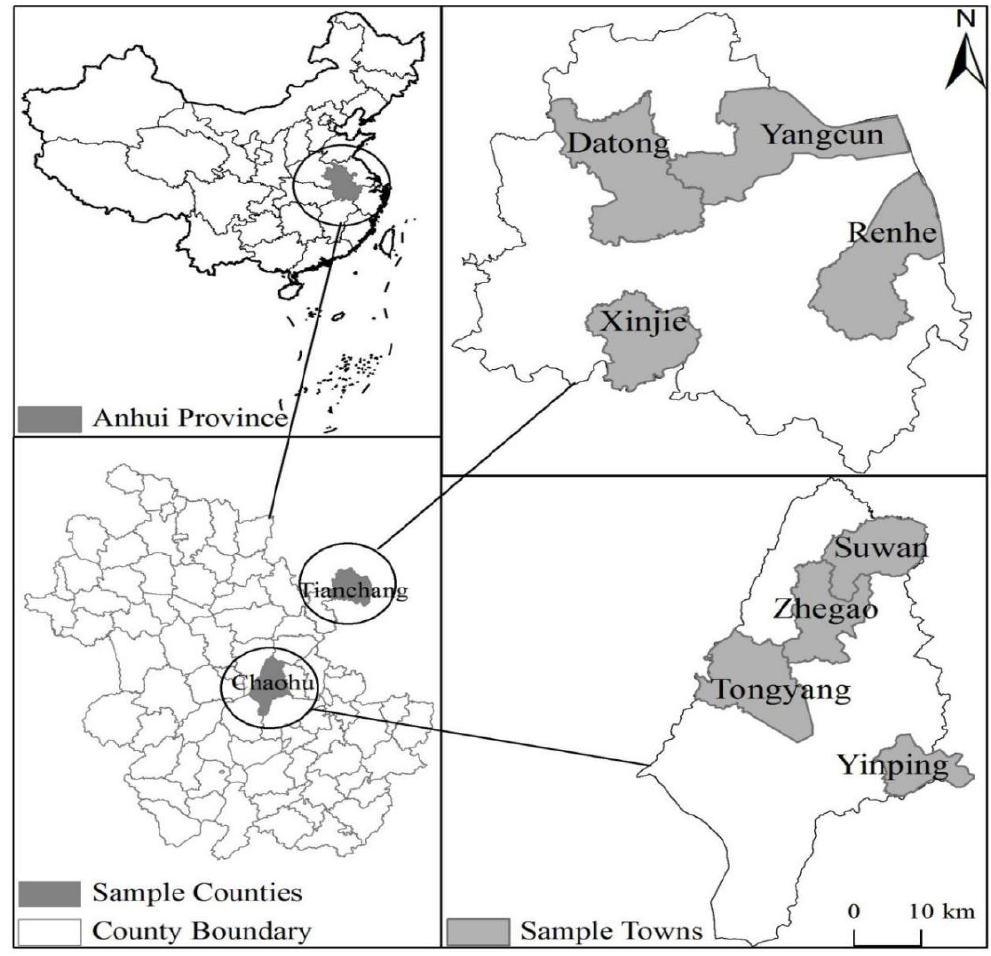
Figure 1. Location of the study regions.